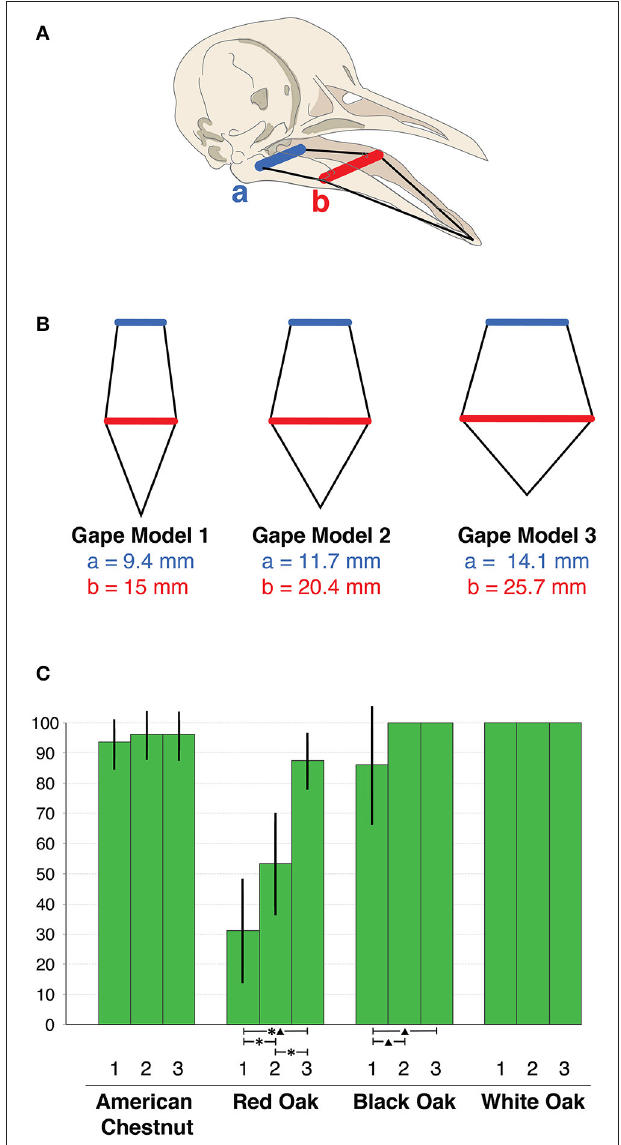
FIGURE 2 | (A) Diagram of a columbid skull showing the constant dimensions of the lower mandibular rami (black lines) and the expandable dimensions of the lower mandibular gape (quadrate expansion: blue line a; mid-rami inflection zone: red line b). (B) The three gape models are shown to relative scale with actual measurements of expandable dimensions listed. (C) Each green bar displays the mean percentage of mast crop samples passing through each gape model for each tree species – gape models indicated on x axis. 95% confidence intervals displayed and statistically different means ( p > 0.05) between gape model pairs indicated by asterisks for one-way ANOVA and a triangle for Kruskall-Wallis tests.